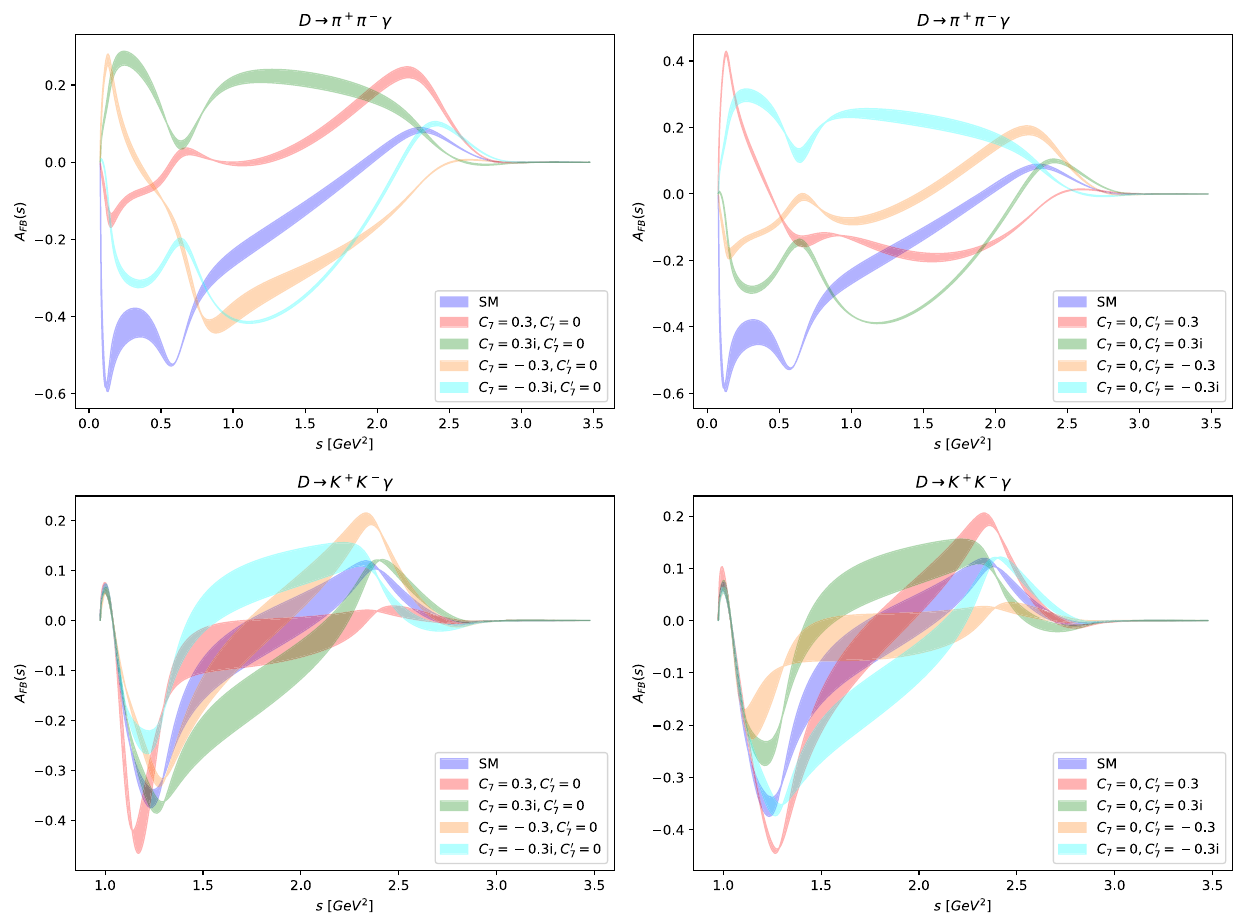
Fig. 9 The forward–backward asymmetry in the SM (blue band) and beyond for the decays D → π + π − γ and D → K + K − γ as a function of s , based on the HH χ PT form